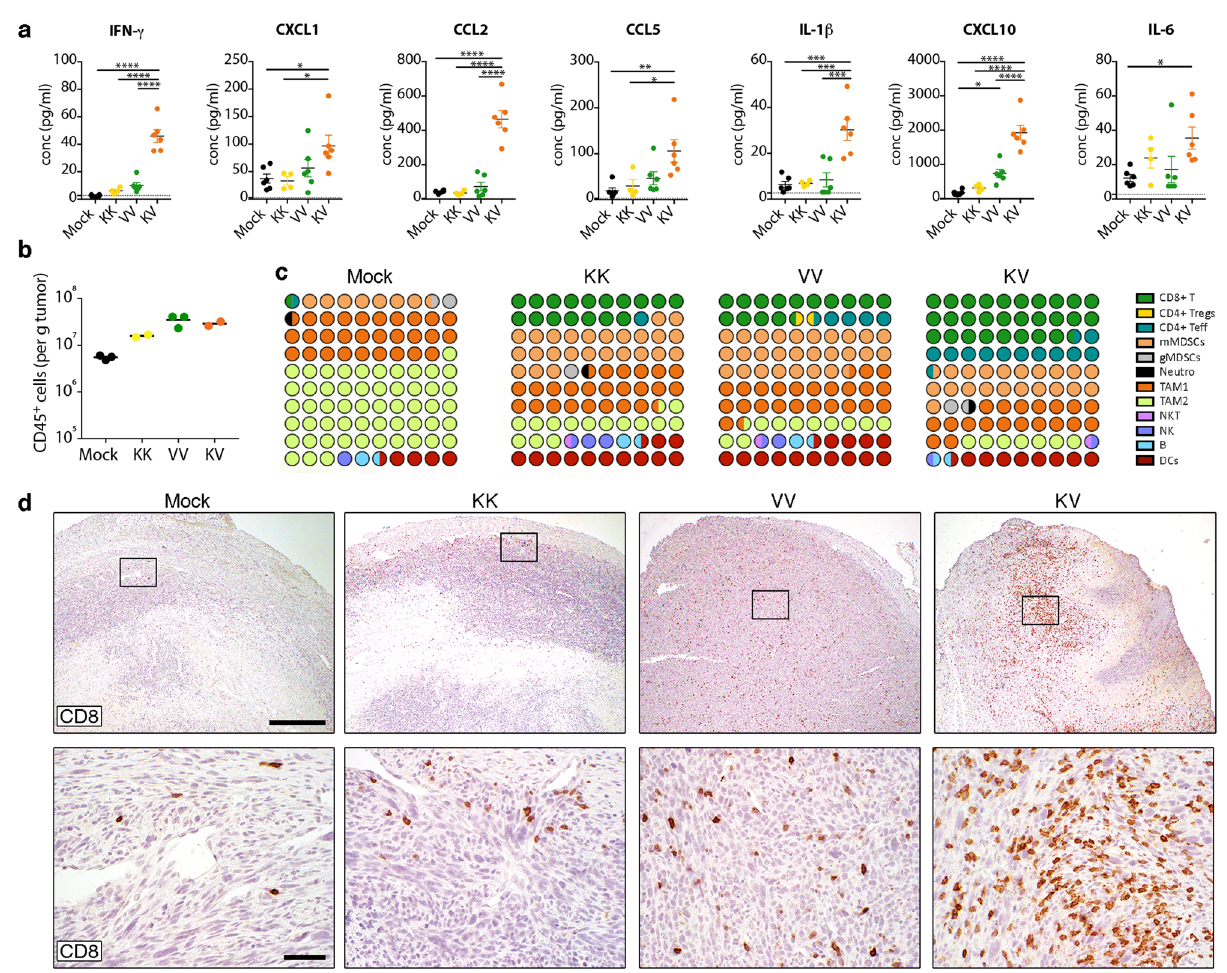
Fig. 4 Remodeling of immunosuppressive tumor microenvironment (TME) after heterologous prime-boost vaccination. Mice bearing palpable TC-1 tumors were immunized as in Fig. 2. a Cytokine and chemokine levels in plasma were quanti fi ed on day 15 and are shown as mean ± SEM ( n = 6 for mock, VV, and KV, n = 4 for KK). One-way ANOVA with Tukey ’ s multiple comparison (* p < 0.05, ** p < 0.01; *** p < 0.001, **** p < 0.0001). Dotted lines indicate the limit of quanti fi cation. b , c Tumors were harvested on day 26 and tumor-in fi ltrating leukocytes were characterized by fl ow cytometry ( n = 3 for mock and VV, n = 2 for KK and KV). b Total CD45 + leukocytes (mean) and ( c ) relative proportions of various immune cell subsets among all leukocytes is shown. d Representative immunohistochemistry images show T cell in fi ltration (CD8) in TC-1 tumors day 23 post tumor implantation after different vaccinations. Lower panel shows higher magni fi cation view of boxed area from upper panel. Scale bars: 500 μ m upper row, 50 μ m lower row. Study ( a ) was performed twice, studies ( c , d ) were performed once. Source data and p -values are provided in the Source Data models that show resistance or very limited responses to oncolytic VSV-GP monotherapy. Murine lymphoma cells E.G7-OVA are Fig. 5a). TC-1 and B16-OVA tumors are susceptible to infection and lysis in vitro, but are protected by IFN-mediated innate